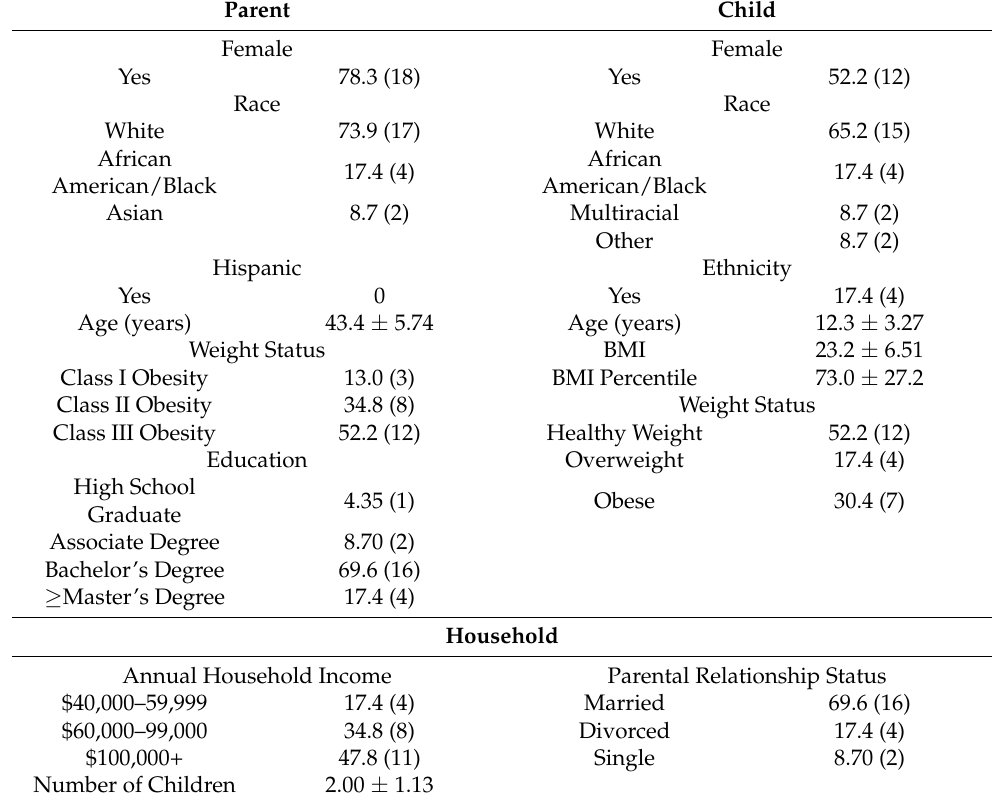
Table 1. Parent and Child Demographics (N = 23) [%(n) or Mean ± SD].